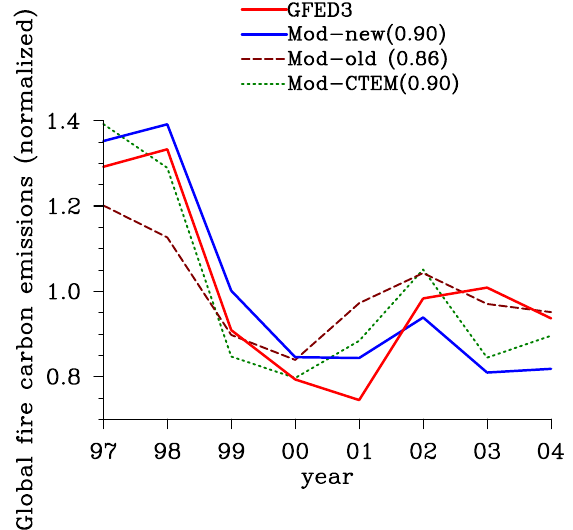
Fig. 17. Same as Fig. 13, but for normalized global fire carbon emis-